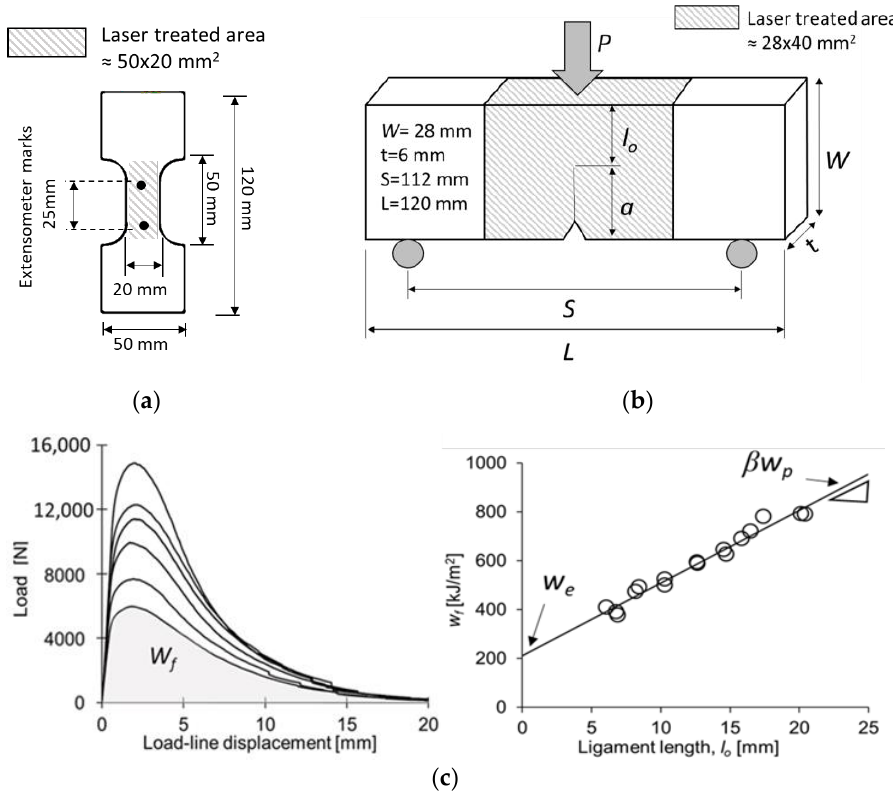
Figure 4. ( a ) Tensile test specimen geometry; ( b ) SENB specimen for EWF testing; W : width, t: thick- ness, L : length, S : Span, l o : original ligament length; a : initial crack length (notch + fatigue pre-crack); ( c ) experimental procedure for w e